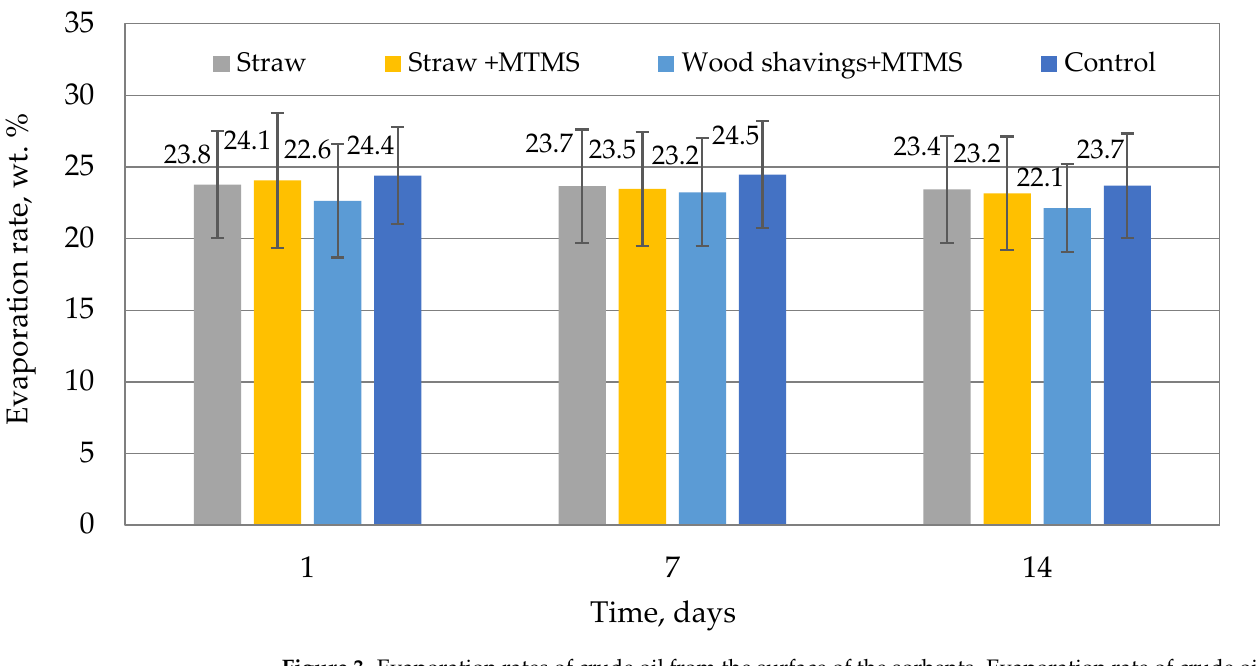
The dynamic oil evaporation of straw, straw + MTMS and wood shavings + MTMS are shown in Figures 3–5.